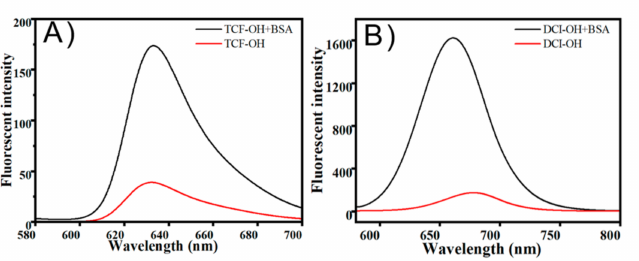
Figure 2. ( A ) Fluorescence spectra of TCF-OH, TCF-OH + BSA in PBS buffer (10 mM, pH 7.4, containing 30% DMSO, v/v ) at 37 ◦ C. ( B ) Fluorescence spectra of DCI-OH, DCI-OH + BSA in PBS buffer (10 mM, pH 7.4, containing 30% DMSO, v/v ) at 37 ◦